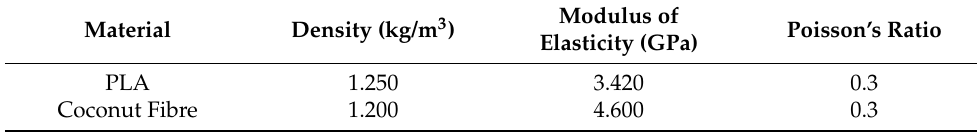
Table 2. Material properties of PLA and coconut fibre used for RVE analysis.